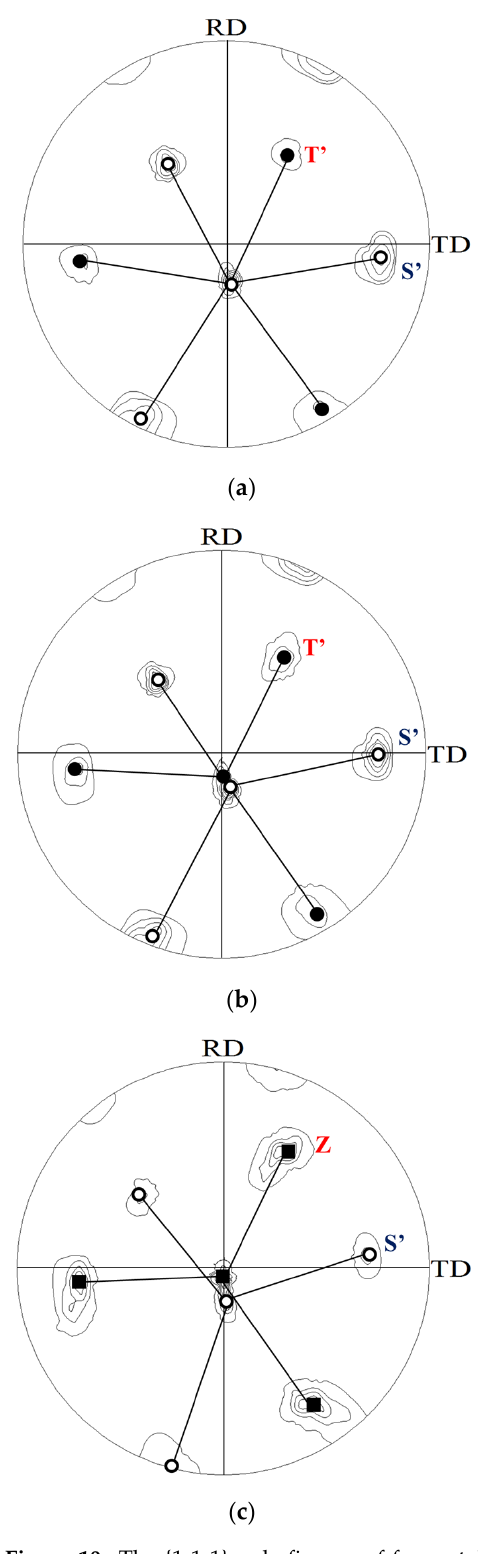
Figure 10. The {1 1 1} pole figures of fcc metal simulated using MTCS-model with single S’ orienta- tion after the reduction ratios of ( a ) 30%, ( b ) 60%, and ( c ) 90%. ○ , ● , and ■ are the pole positions on {1 1 1} pole figure of the orientation close to S’ (1 2 3)[4 (cid:3365)1 (cid:3365)2] , T’ (3 2 1)[2 1(cid:3365) 4(cid:3365)] , and Z (1 1 1)[1 0 1(cid:3365)] , respectively.